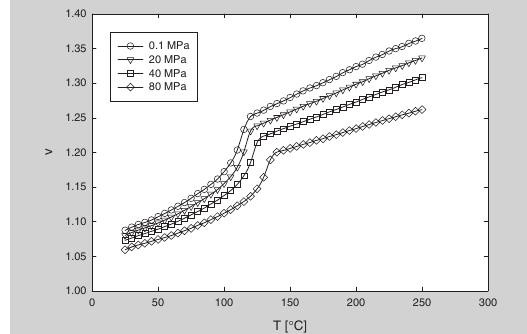
Figure 7 (left): Comparison of the pressure coefficient of the viscosity obtained by different methods. Figure 8 (right): PVT data for the LLDPE sample used in this